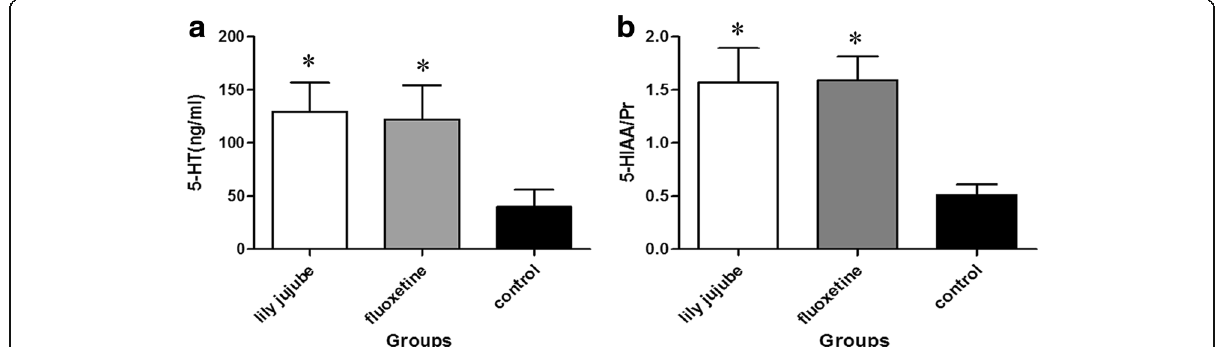
Fig. 6 Measurement of serum 5-HT and brain 5-HIAA after treatment. a : Measurement of serum 5-HT; b : Measurement of 5-HIAA/Pr (×10 -3 ) of brain tissue homogenate. Note: The presented data are mean + S.E.M. Statistical analysis was carried out by one way ANOVA. *< 0.05 compared with the control